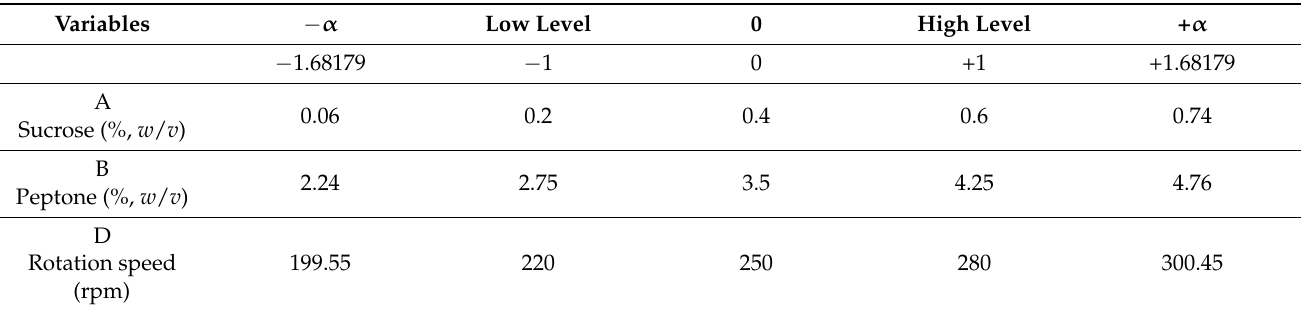
Table 3. Different level of variables in CCD design.